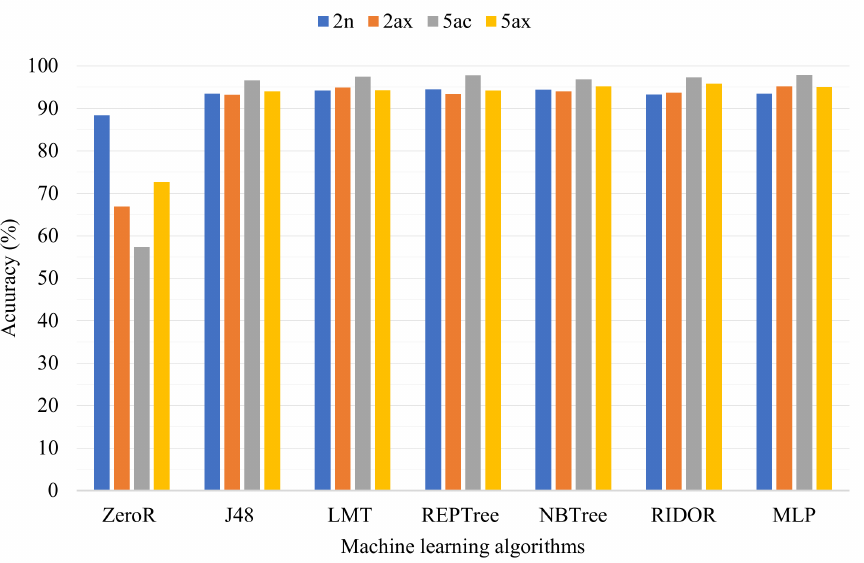
Figure 2. Percentage (%) of correctly classified labels by each of seven machine learning (ML)